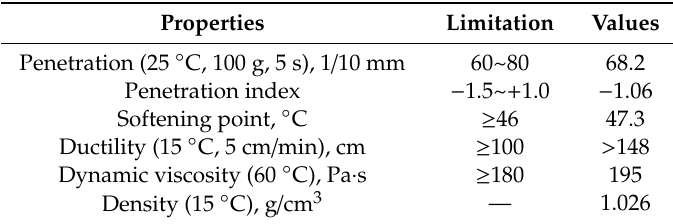
Table 1. Physical properties of 70# original